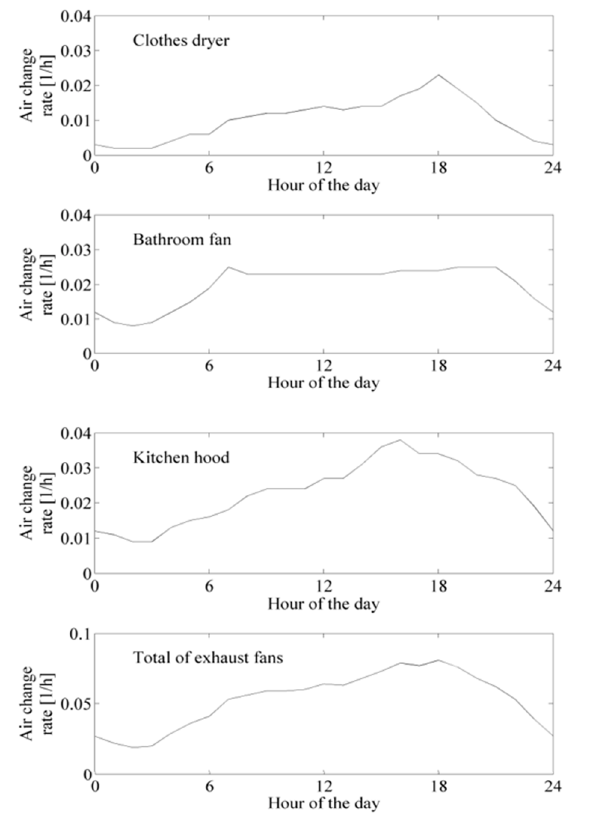
Figure 3. Average daily profile of air change rate generated by the use of the clothes dryer, the bathroom fan, the kitchen hood and the sum of the three exhaust